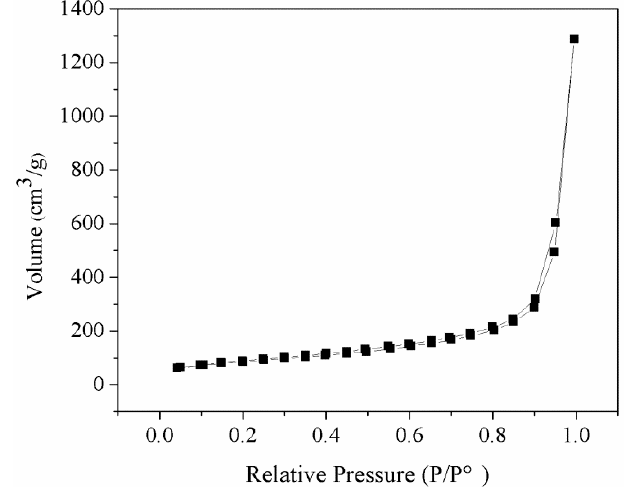
Figure 2. Nitrogen adsorption–desorption isotherm.